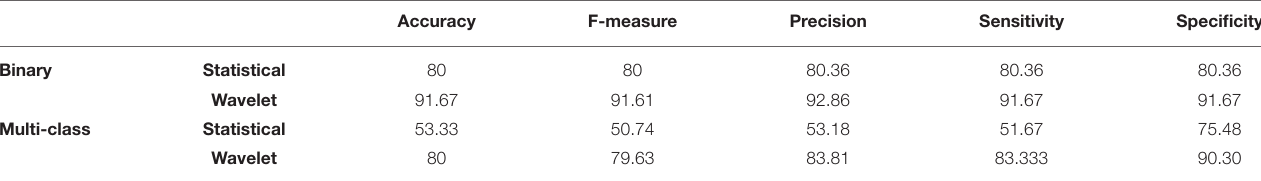
TABLE 3 | Performance metrics for ensemble